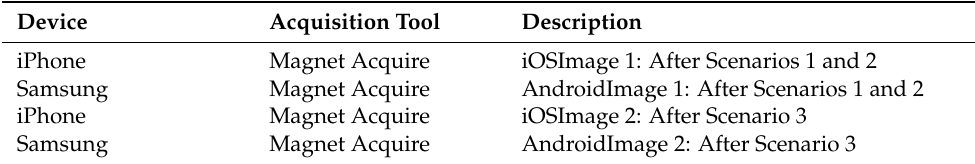
Table 5. Detailed acquisition